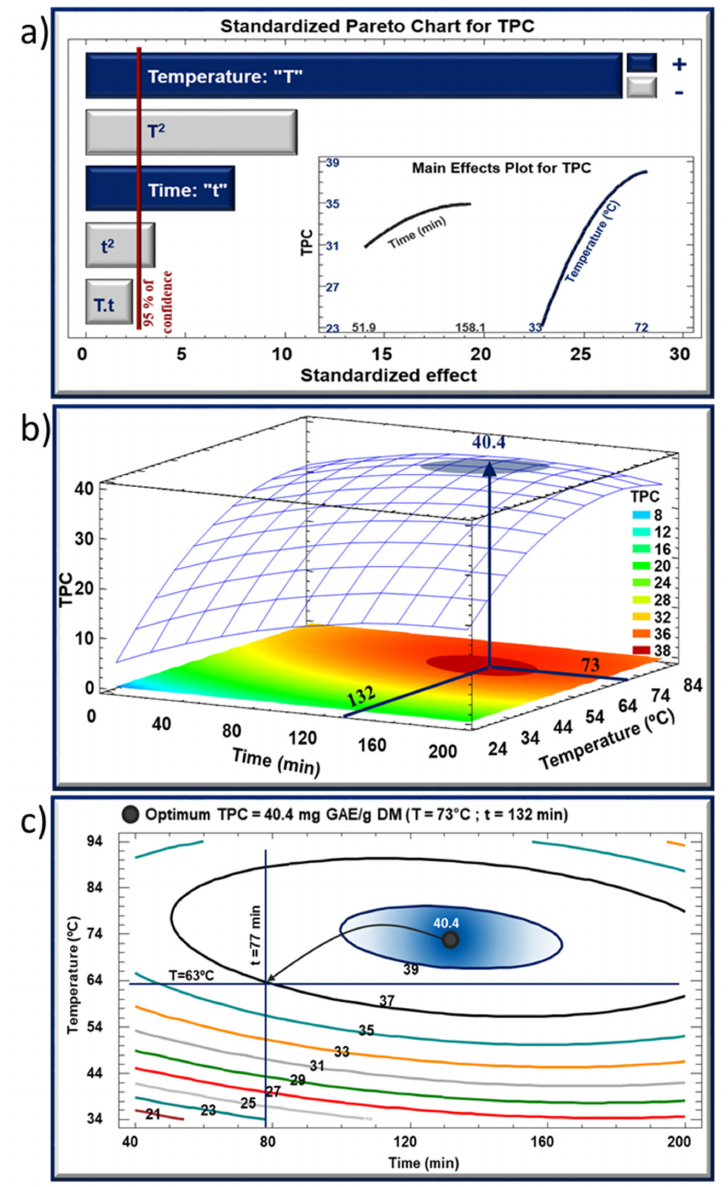
Figure 2. ( a ) Standardized Pareto chart, ( b ) the corresponding estimated response surface mesh of TPC, and ( c ) the corresponding estimated response contours for TPC recovery using IR-assisted